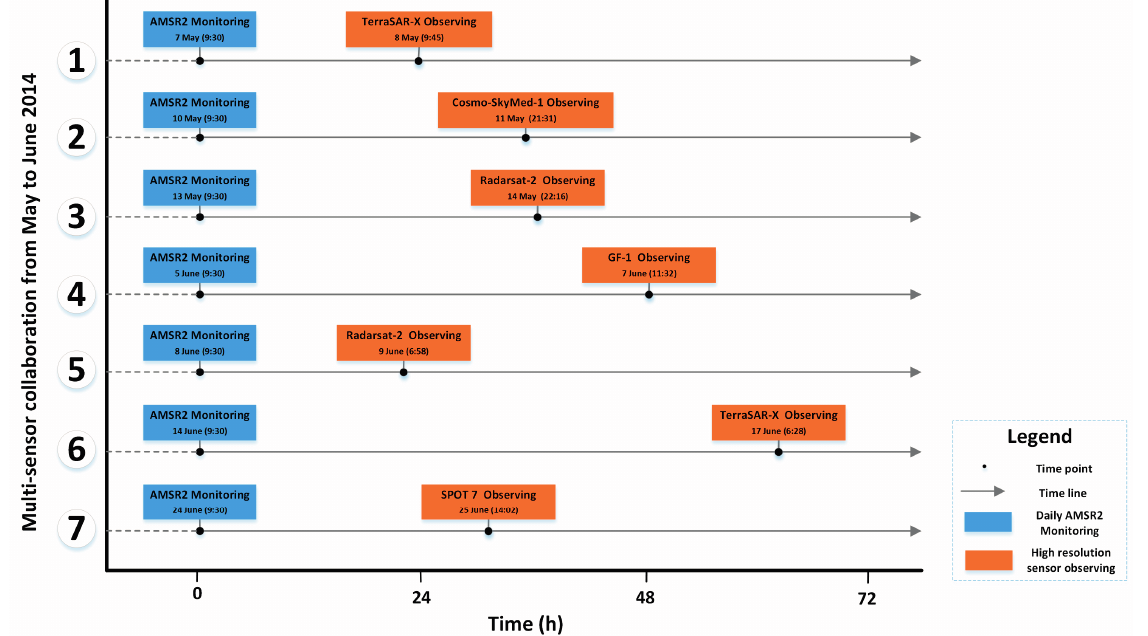
Figure 11. An overview of the local time points of the daily AMSR2 acquisitions and high-resolution data acquisitions in the study area.